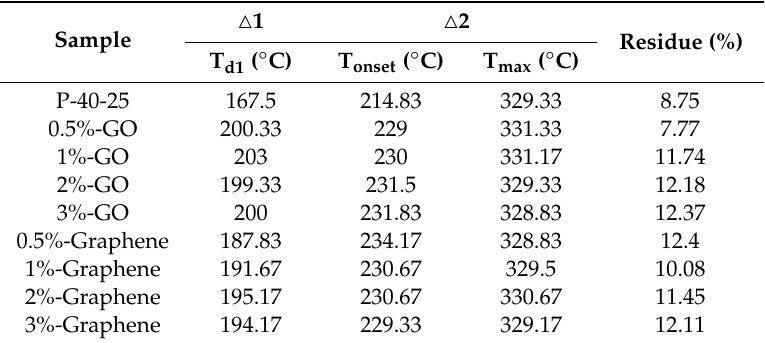
Table 2. Thermogravimetric analysis (TGA) results for P-40-25 incorporated with graphene oxide (GO) and graphene.